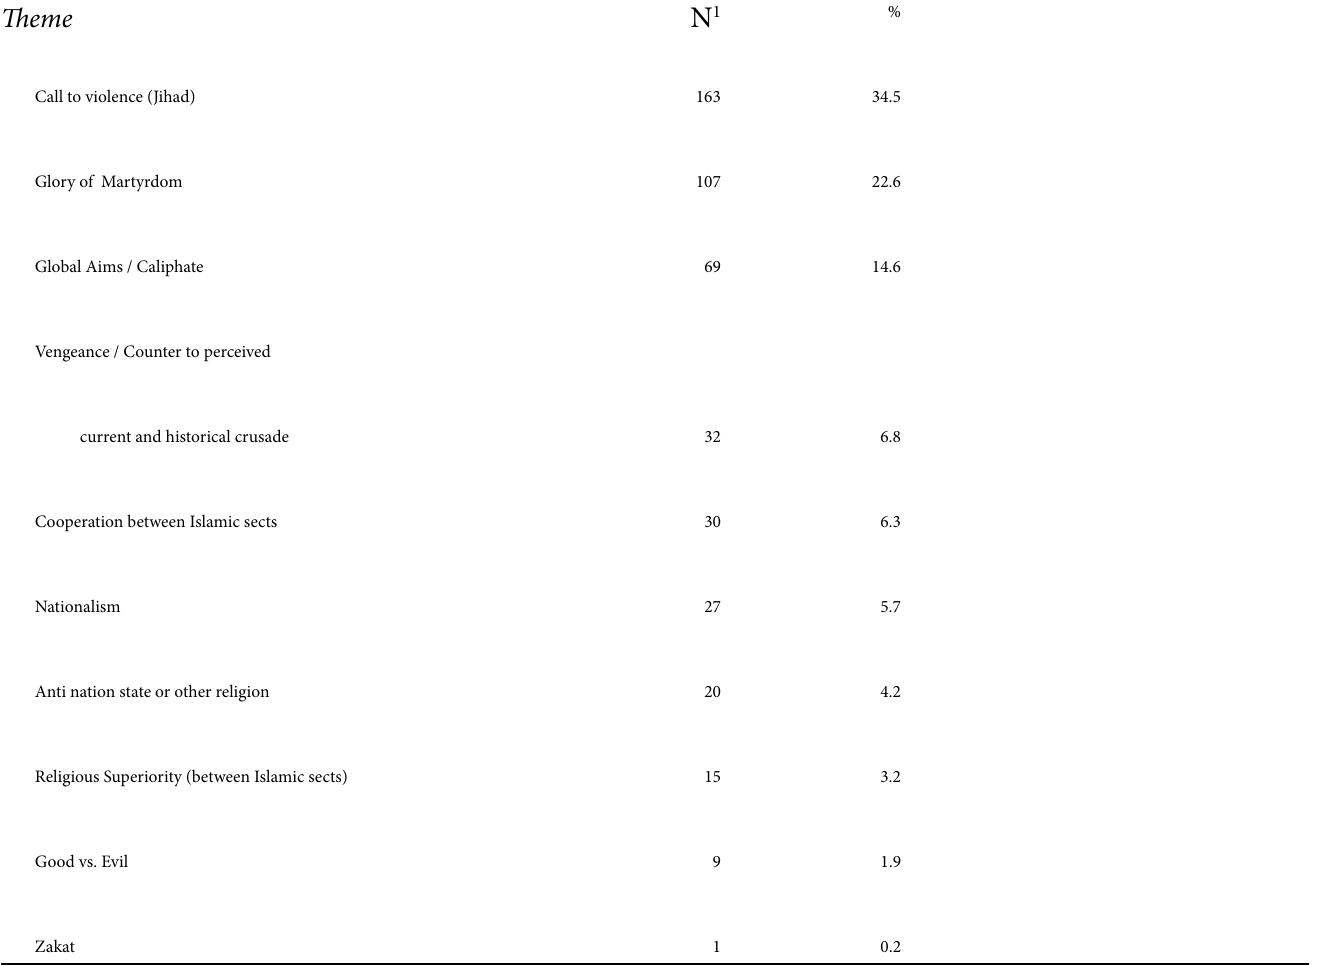
Table 2: Overarching themes used by Al Qaida, Affiliates and Associates in Internet postings Theme N 1 % Call to violence (Jihad) 163 34.5 107